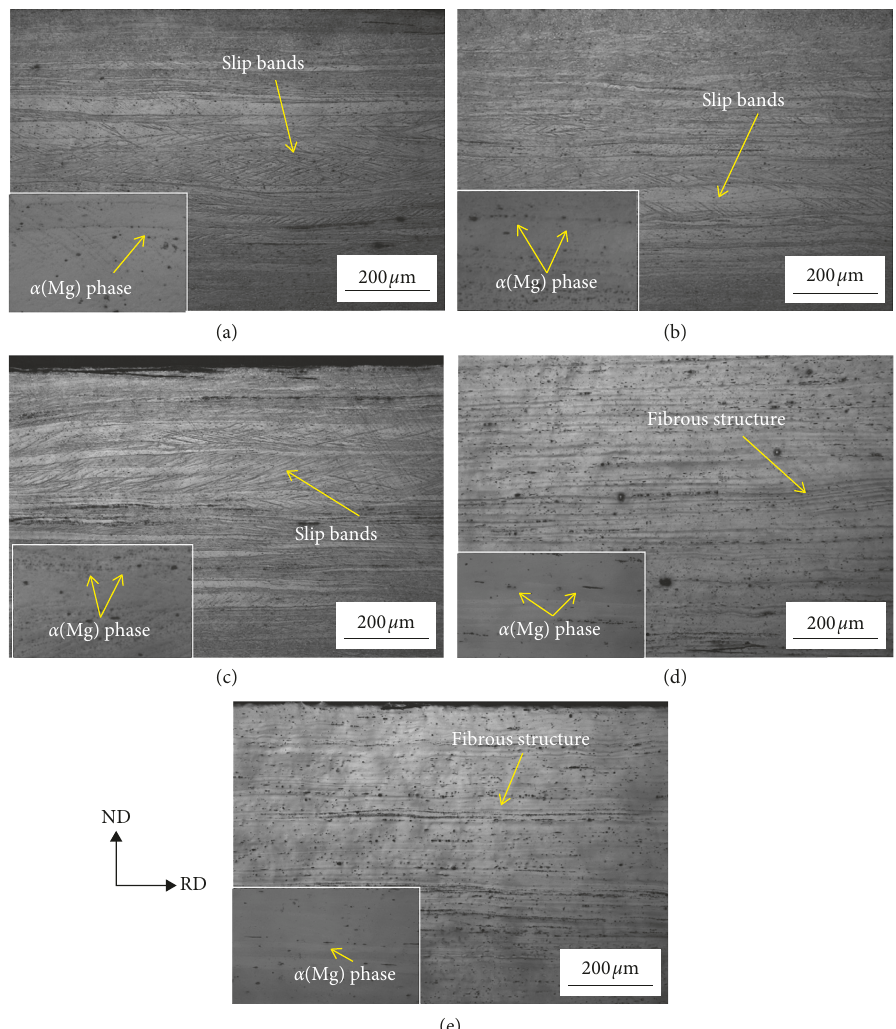
Figure 2: OM images of the cold-rolled specimen after hot rolling under different temperatures. (a) 100 ° S ; (b) 150 ° S ; (c) 200 ° S ; (d) 250 ° S ; (e) 300 ° S